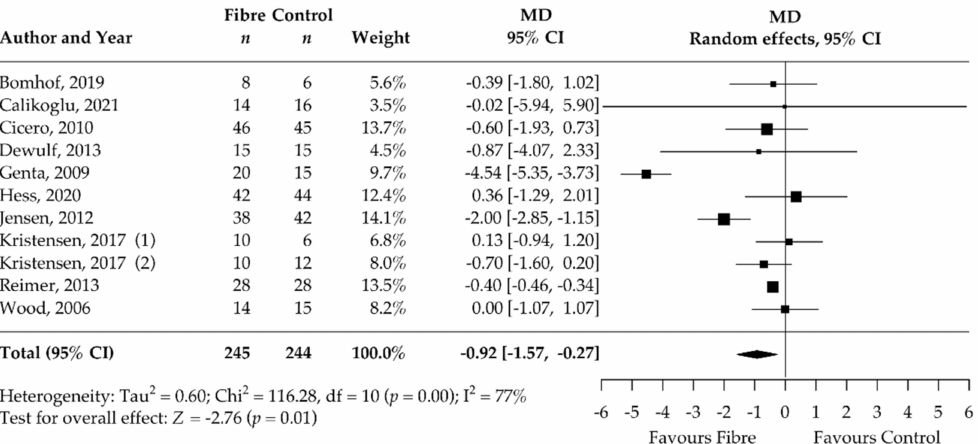
Figure 7. Isolated soluble dietary fibre supplementation significantly decreased HOMA-IR in over- weight and obese people ( n = 489). Black rectangles represent MD for each study; the size of the rectangle is proportional to the weight of the study for the pooled effect. Horizontal line indicates 95% CI. The black diamond summarises the pooled MD data. MD = mean difference; (1)/(2) indicate cohort 1 and 2 of study